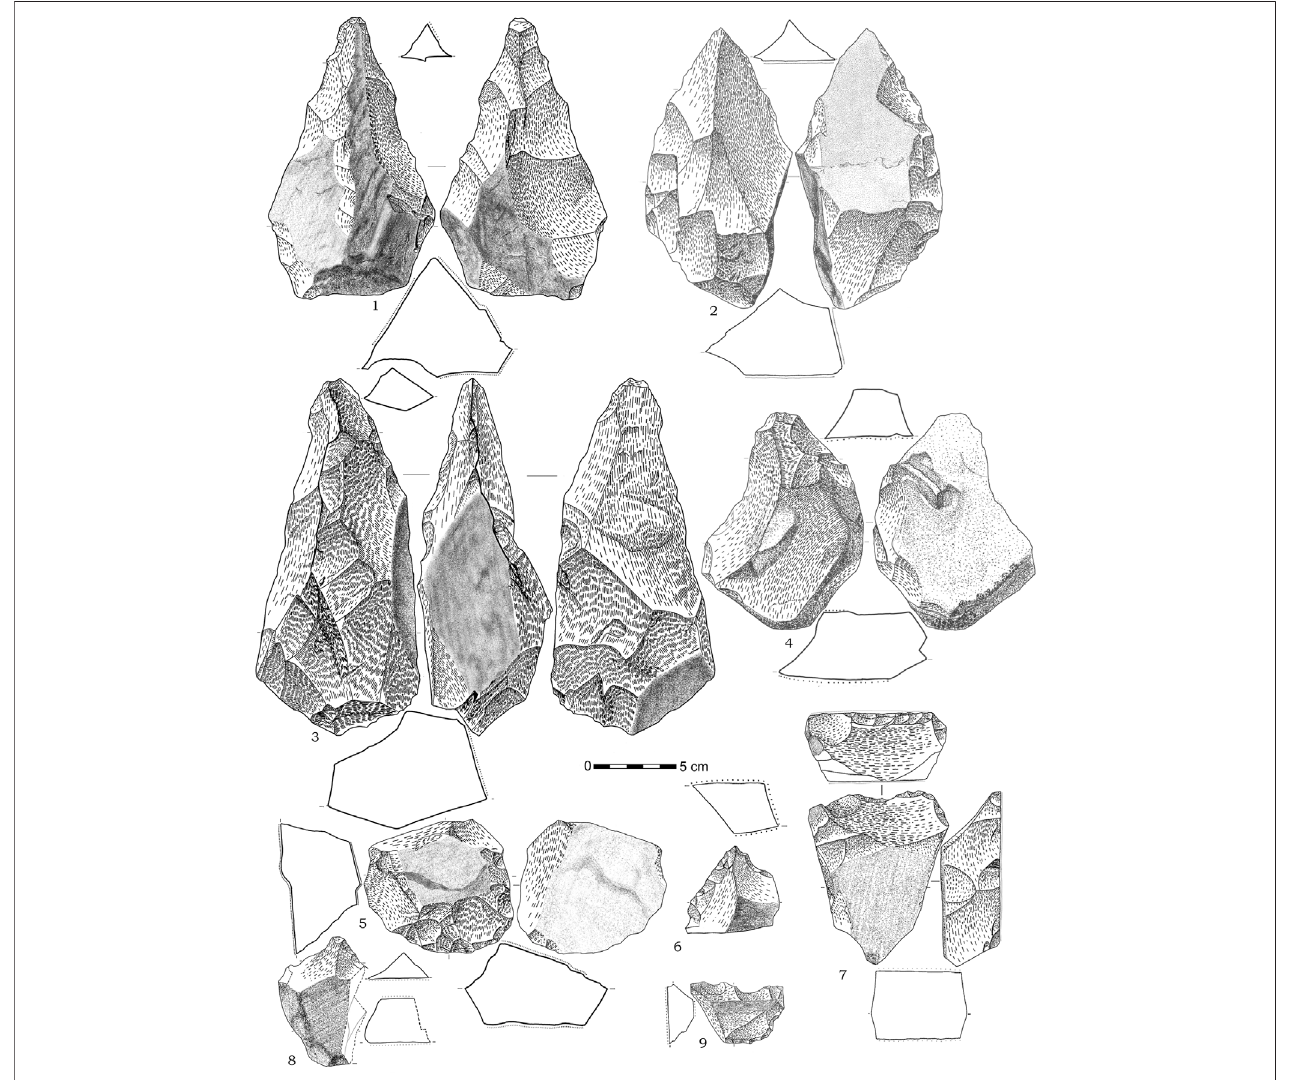
FIGURE 13 | Trihedral picks (1-4) and other pebble tools (5-9). All on quartzite.